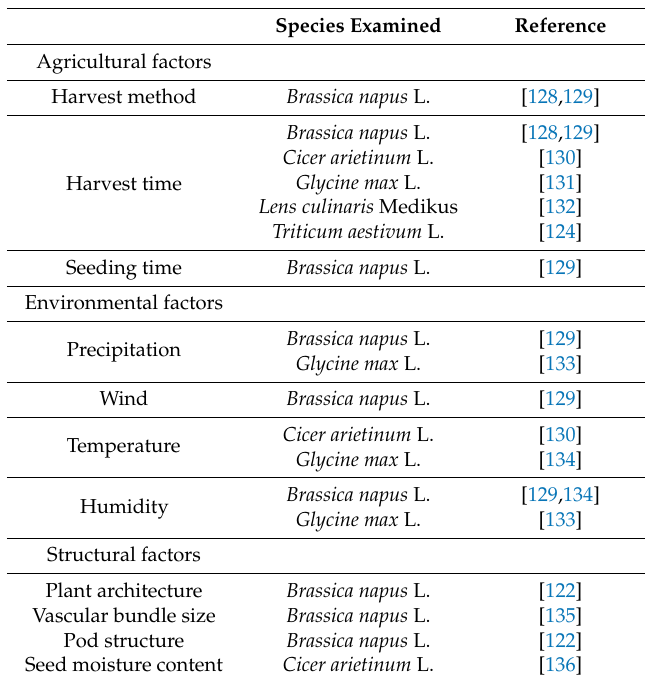
Table 2. Factors effecting crop yield due to